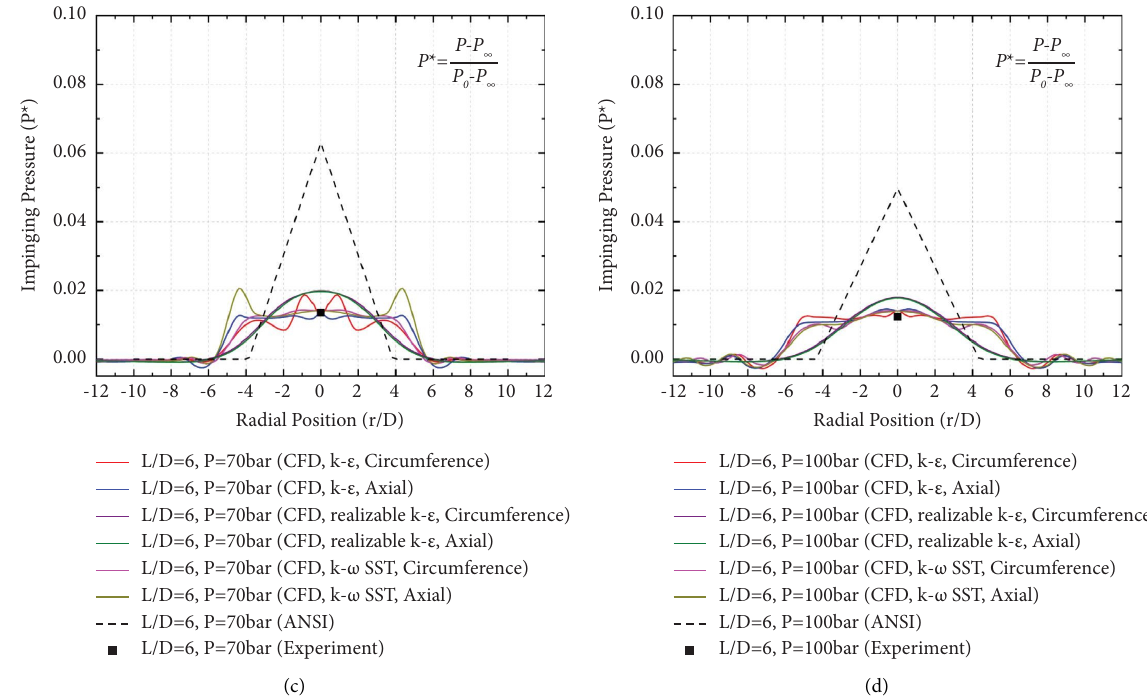
Figure 7: Impinging pressure on the inner surface of piping covers: (a) gap 3mm, P P 0 � 70 bar, and (d) gap 6mm, P 0 � 100bar.